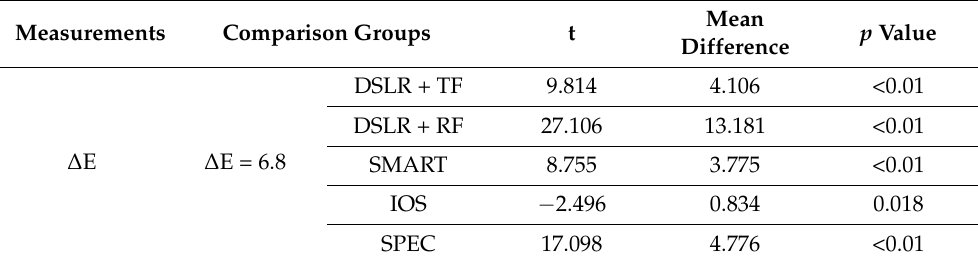
Table 5. Accuracy: one sample t -test used to compare between ∆ E from study groups and the border of clinical acceptance ( ∆ E =